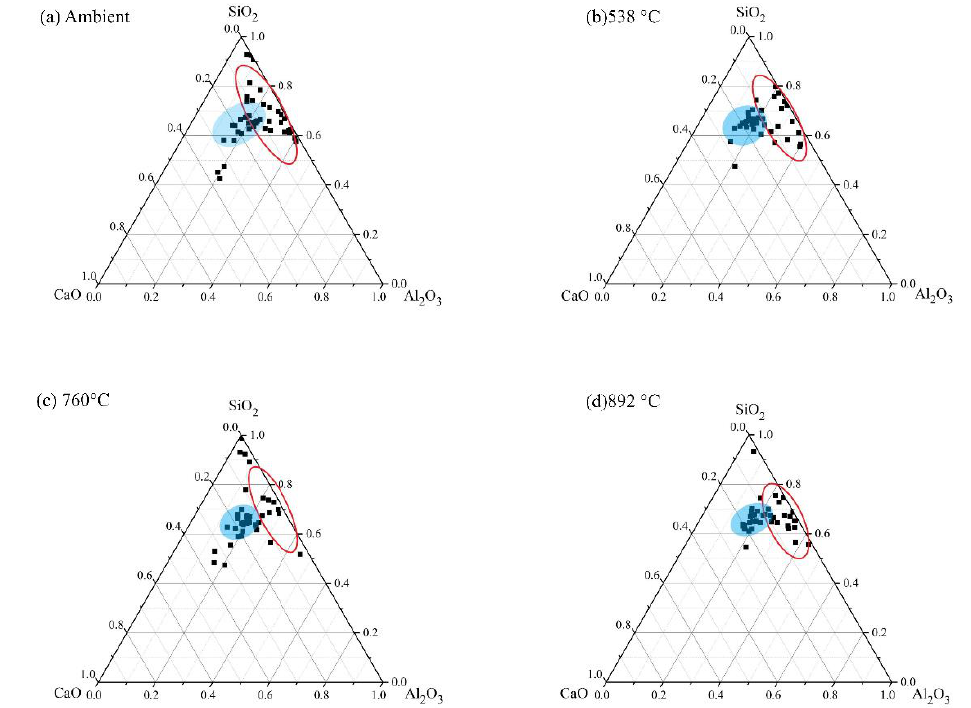
Figure 21. Ternary representation of EDS data for FS 30P-1.4 exposed to high temperatures.